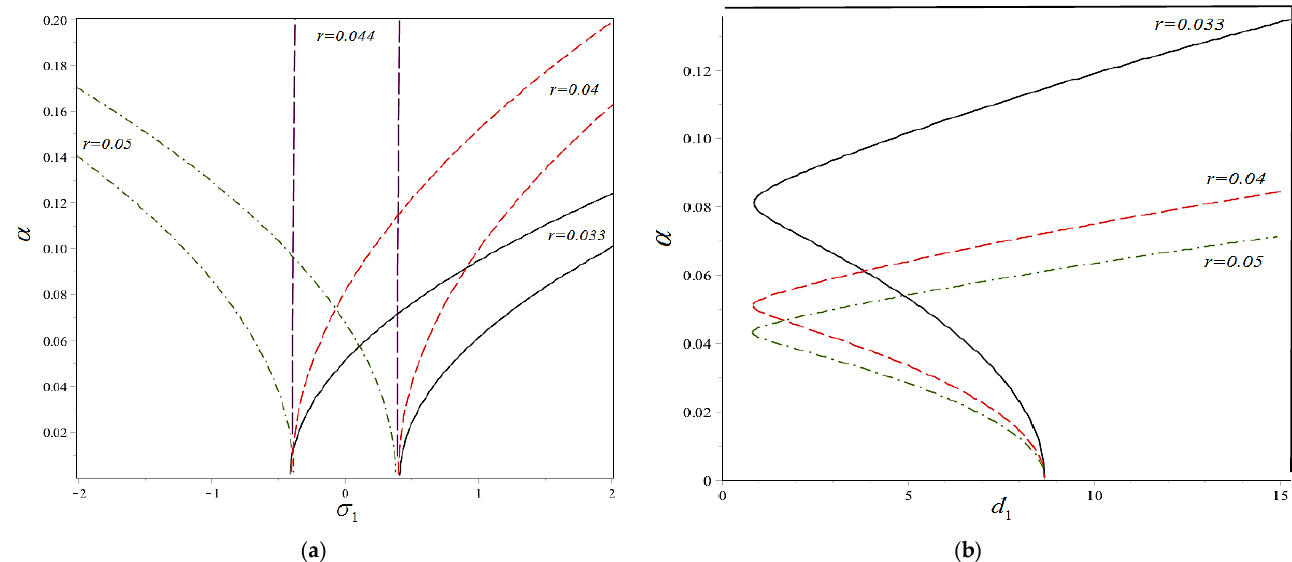
Figure 5. ( a ) Quadratic curvature waviness effect on the frequency response in the parametric resonance; ( b ) quadratic curvature waviness effect on the response curve in the parametric resonance.